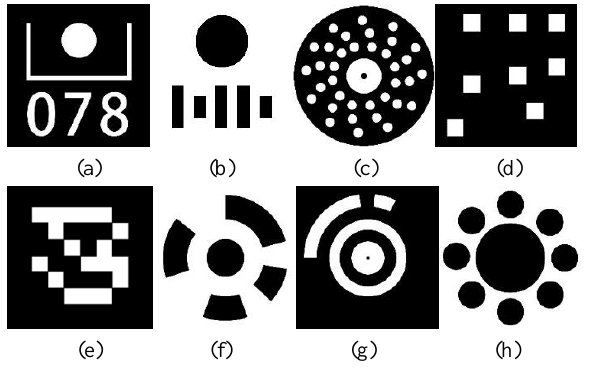
Figure 1. Several typical artificial coded target. (a) Caesar, 2005; (b) Wong, 1988; (c) Ahn, 2001; (d) Fraser, 1997; (e) Fiala, 2010; (f) Schneider, 1993; (g) Van Den Heuvel, 1993; (h) Ma,